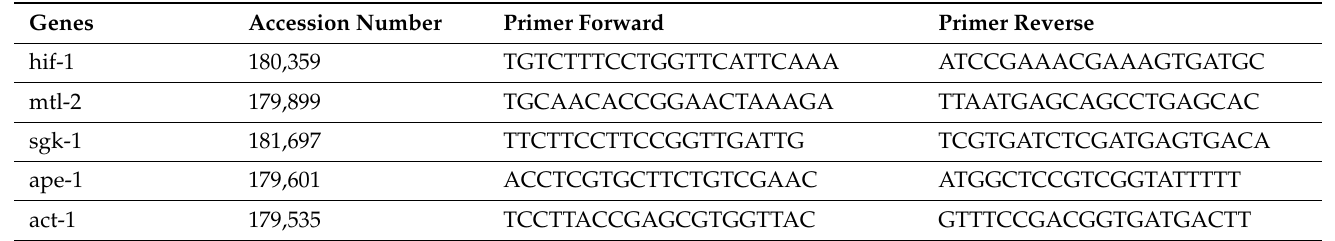
Table 1. Primers used for qRT-PCR analysis.